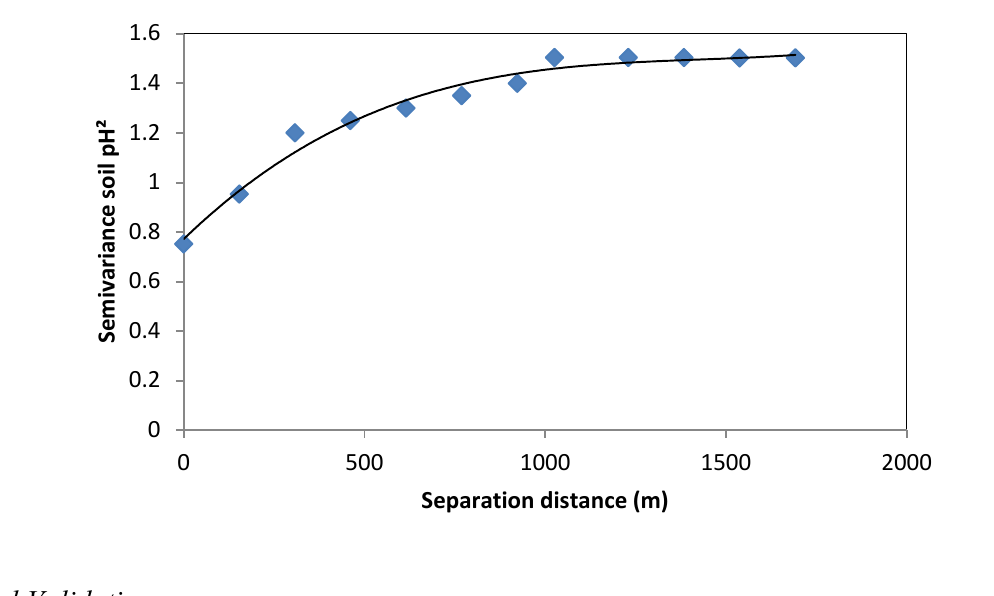
Figure 3. Fitted Variogram model for soil